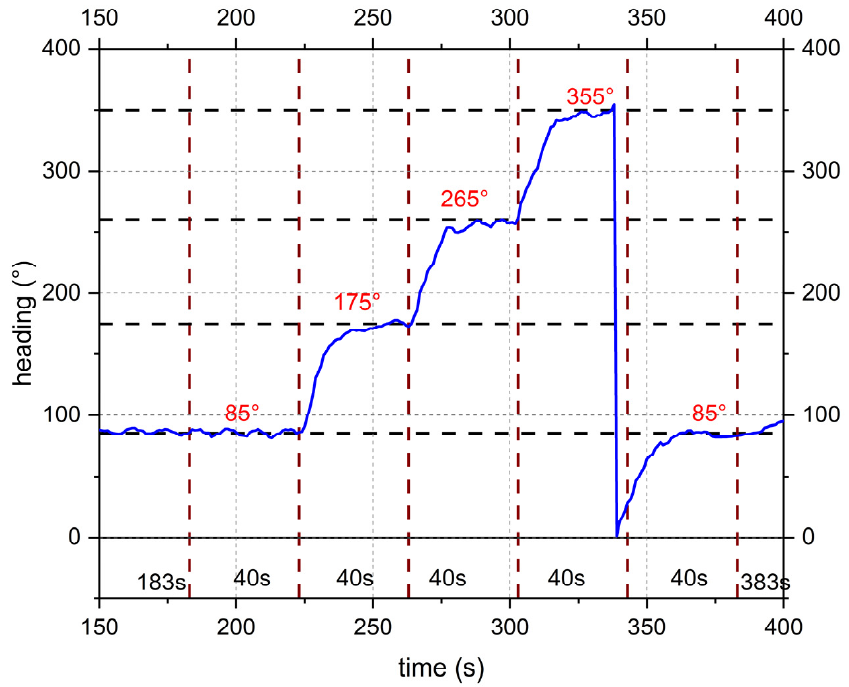
Figure 11. The heading changed with time when it swam the rectangle, it swam stably for 40 s for each side of the rectangle, and the reference headings were 85, 175, 265, and 355°, respectively.